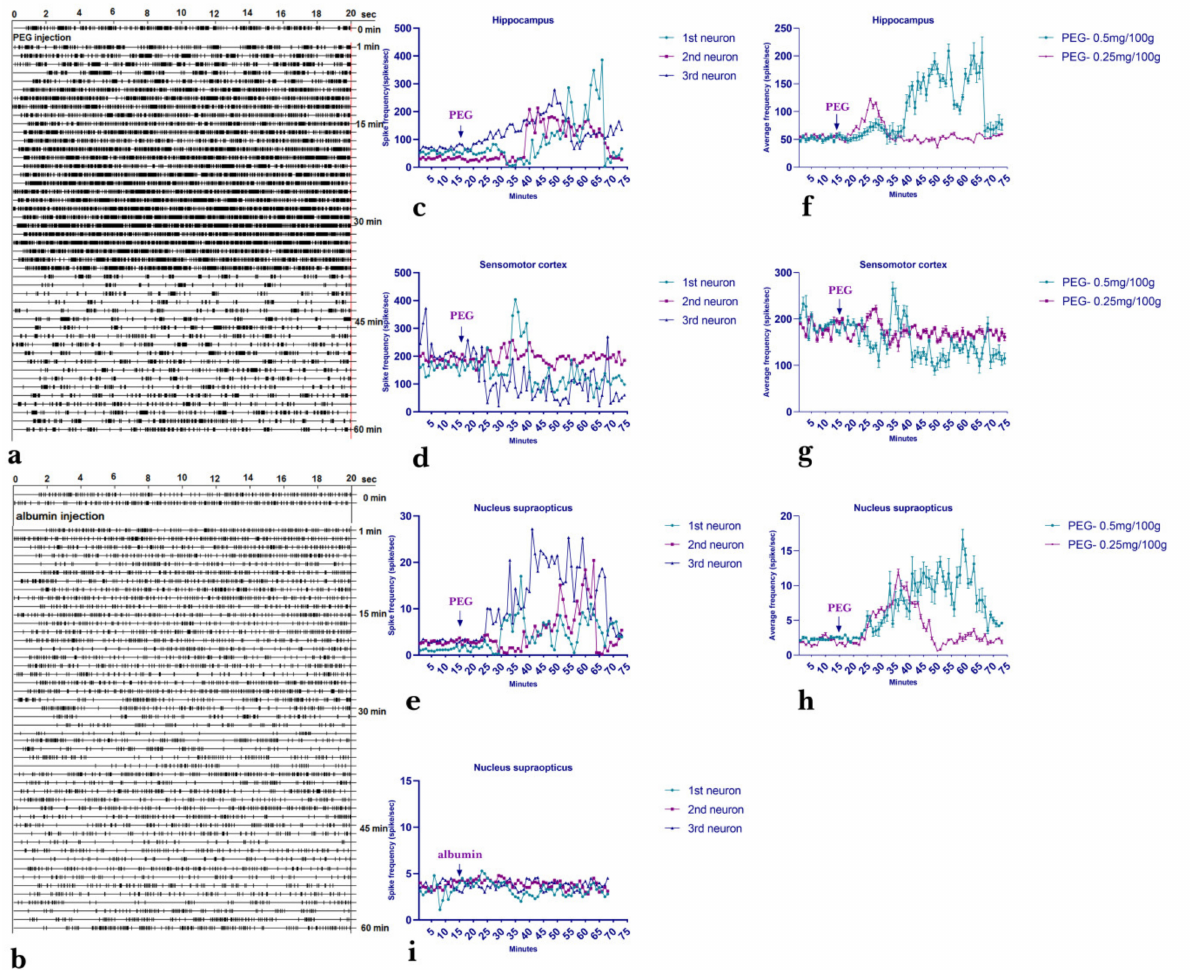
Figure 5. Spike activity of single neurons following acute injection of PEG. Impulse flow of a single hippocampal neuron (shown by the amplitude discriminator selection) in case of PEG ( a ) and albumin ( b ) injection; spike activity is presented as a “raster” in real time (time bin 20 sec). ( c – e ) Spike activity changes of single neurons of hippocampus ( n = 3), sensomotor cortex ( n = 3) and nucleus supraopticus ( n = 3), from the initial level to 60 min after i/p injection of PEG (0.5 mg/kg). Abscissa— exposure time of PEG (minute), Ordinate—number of spikes (spike/sec) during registration (time bin 20 sec). Excitation effects are more expressed in hippocampus and nucleus supraopticus. ( f – h ) average spike frequency (mean ± SEM) of hippocampal neurons ( n = 60) and neurons from the sensomotor cortex ( n = 60) and nucleus supraopticus ( n = 60) in case of different doses of PEG. ( i )—spike activity changes of single neurons of nucleus supraopticus ( n = 3) after albumin